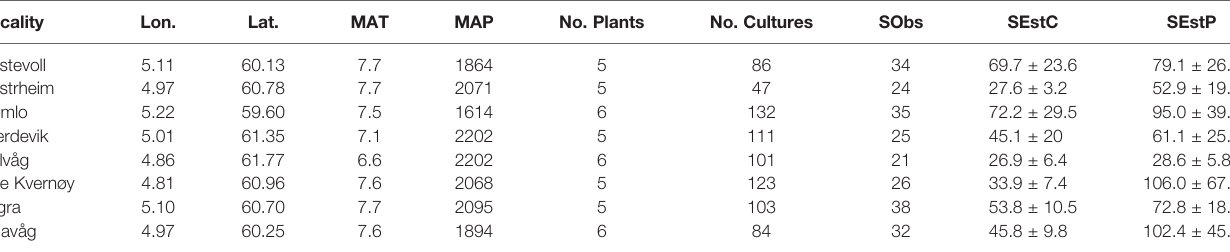
TABLE 1 | Overview of the locality position, climate, culture richness, species richness and richness estimates across the eight Norwegian coastal heathland localities. Locality Lon.